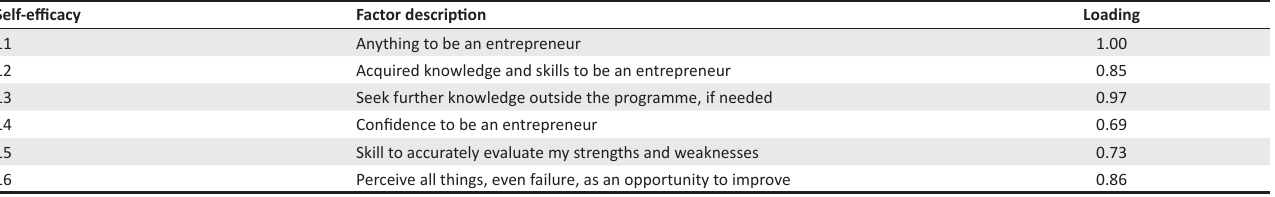
FIGURE 3: Confirmatory factor analysis on participants’ perceived self-efficacy. TABLE 5: Self-efficacy factor